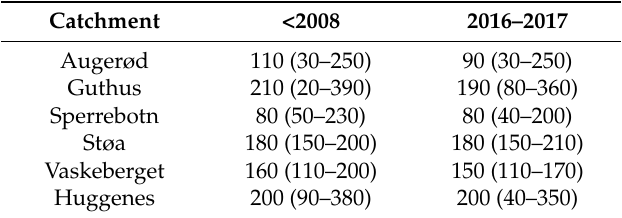
Table 6. Average ammonia lactate (P-AL) values (mg P-AL kg − 1 ) in each of the catchments, minimum and maximum values in parenthesis ( n = 3–7 samples ha − 1 ). P-AL values of 0–40 are classified as